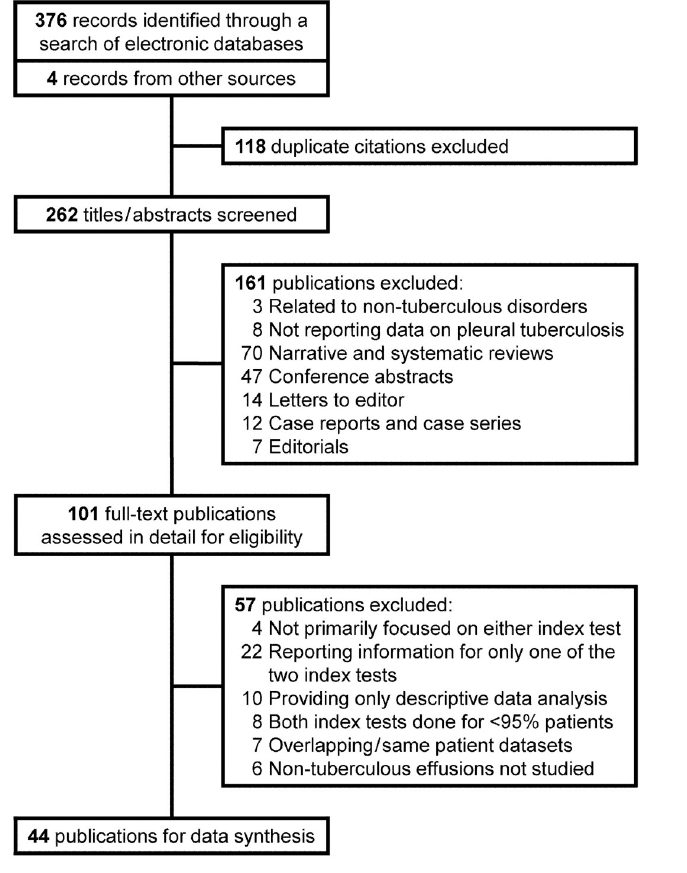
Fig 1. Study selection